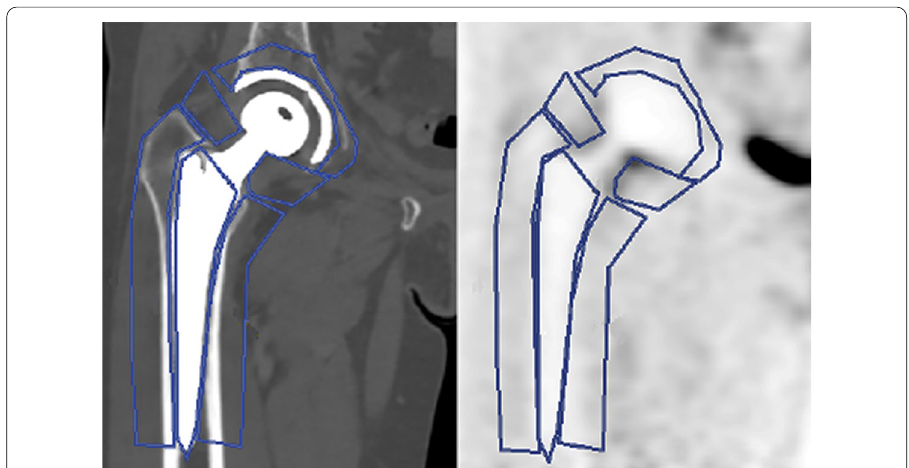
Fig. 4 Typical ROIs outlined on corresponding CT and PET images. ROIs correspond to acetabular, medial and lateral neck, medial and lateral diaphysis, and shaft areas. They were drawn in coronal planes through the midplane of the